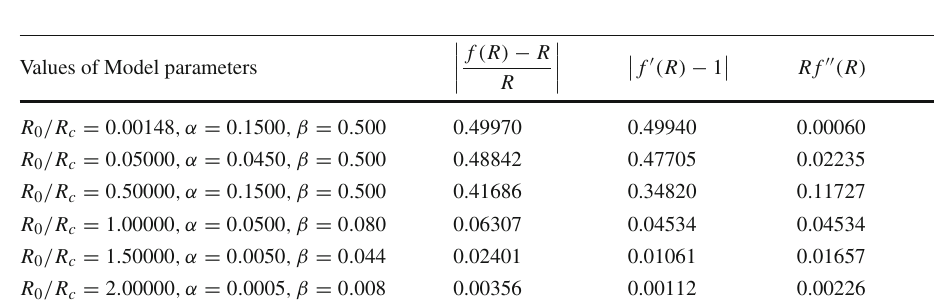
(cid:11) (cid:11) (cid:11)